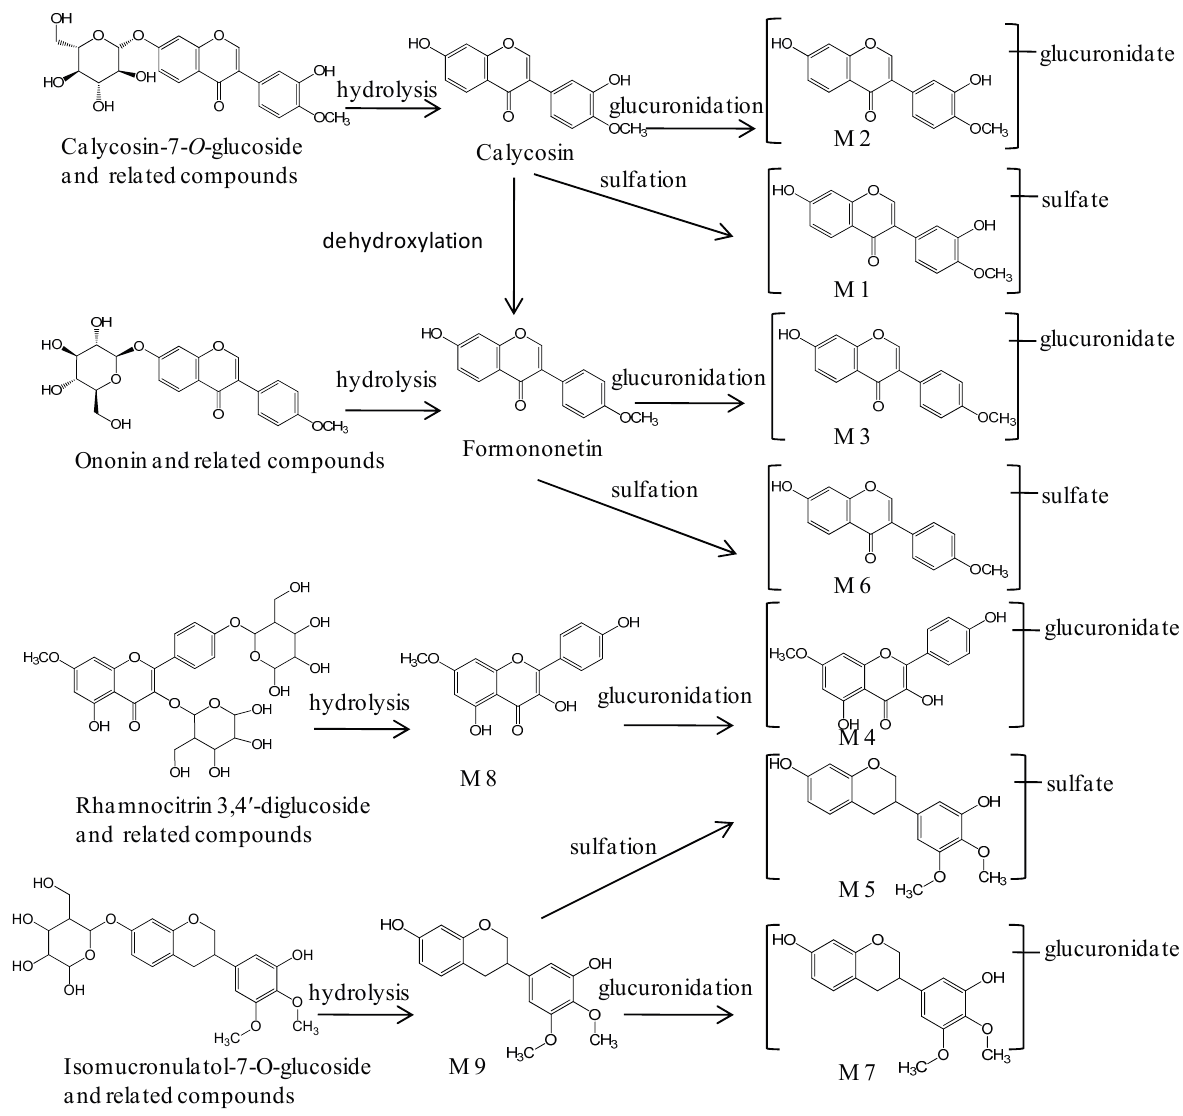
Figure 3. The possible metabolic pathways of nine metabolites in Balb/c mice orally administered with